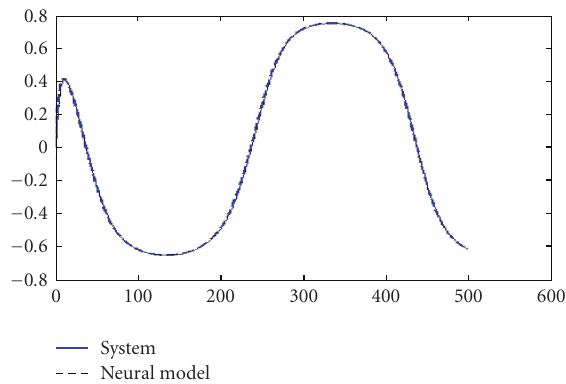
Figure 4: Evolution of the system output and the neural model output ( ε ∈ stability domain).